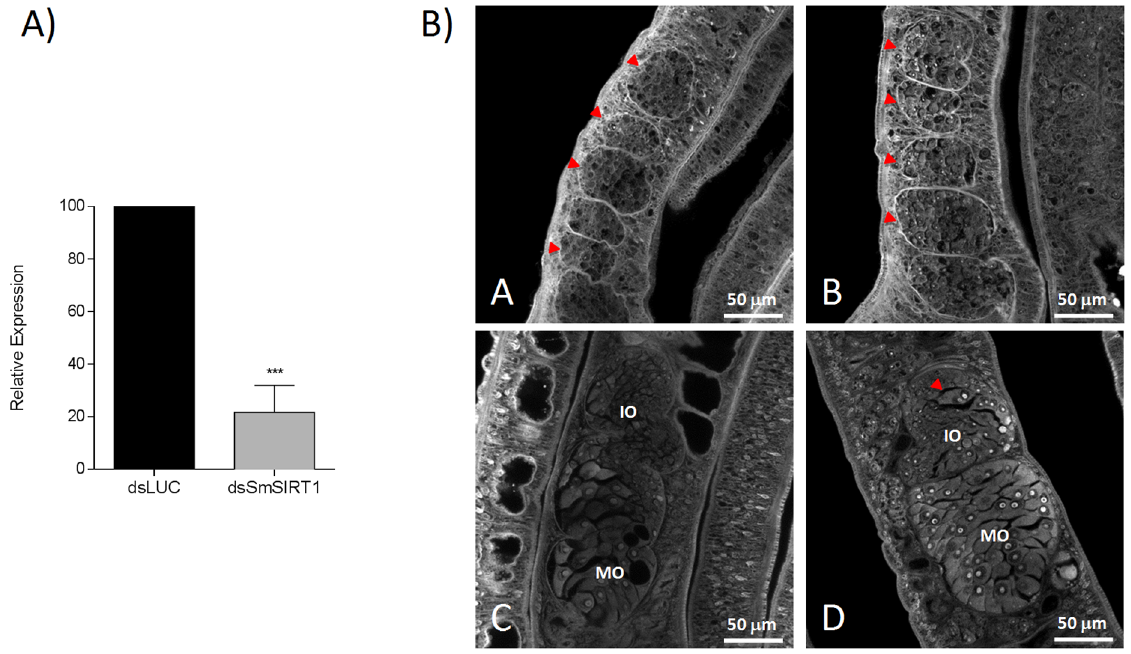
Figure 9. Effects of SmSirt1 transcript knockdown in adult worms. RNA interference was carried out by the electroporation of adult worms with dsRNA for SmSirt1 or luciferase (negative control) as described in the Methods section. (A) RNAi led to a reduction of about 80% in the level of transcripts for SmSirt1 compared to controls knocked down for the irrelevant luciferase gene. (B) Microscopic examination was carried out 5 days after RNAi treatment as previously. This treatment caused no obvious morphological changes to male worm testes (B) compared to the control (A). Testes are indicated by red arrows. In contrast, RNAi treatment led to a marked increase in mature oocytes in the ovaries (D) compared to the control (C) particularly in the posterior part (MO). A mature oocyte in the anterior part of the ovary (IO), normally containing only immature oocytes (D) is arrowed. Results shown are representative of four independent experiments. and H. sapiens (HsSirt1: AAH12499.1). A putative PEST motif and PKB phosphorylation site are overligned in red. (TIF) Figure S2 Alignment of the five SmSirt5 splicing isoforms. Alignment of the complete amino acid sequences of the isoforms shows the use of an alternative 5 9 exon (isoforms 3 and 5), the use of alternative splicing sites within exon 3 (isoforms 1, 2 and 4) or the use of an alternative 3 9 exon (isoforms 4 and 5). (TIF) Table S1 List of oligonucleotides used. (XLSX)